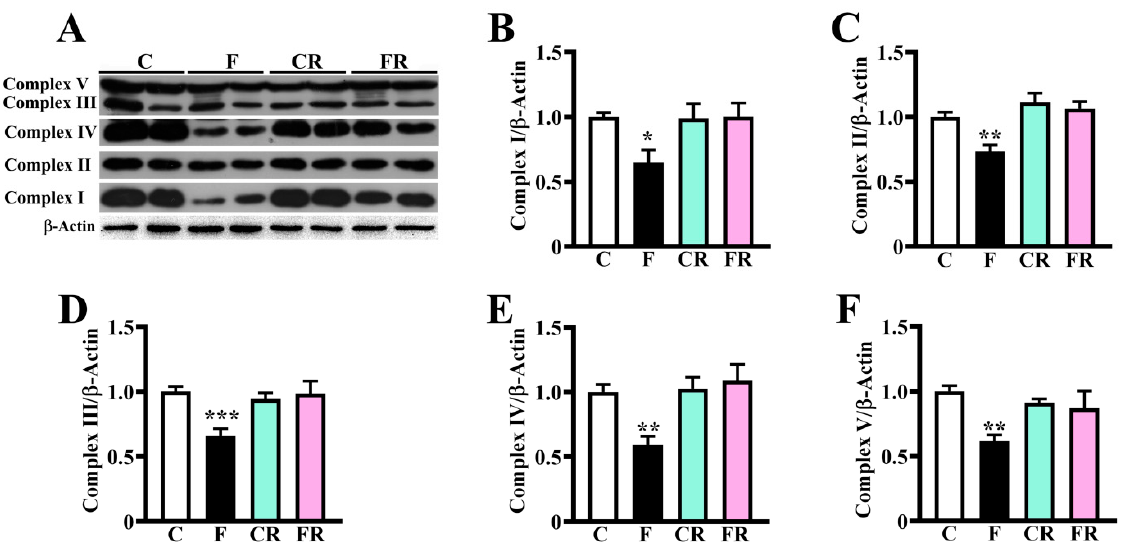
Figure 3. Mitochondrial respiratory complexes amount in rat hypothalamus. The amount of mito- chondrial complex I, II, III, IV, and V was measured in protein extracts from the hypothalamus of control adolescent (C), fructose-fed adolescent (F), young-adult control rescued (CR), young-adult fructose-rescued (FR) rats. Samples were analyzed by 12.5% SDS-PAGE and western blotting. After the detection of immunocomplexes (by mouse anti-OXPHOS and GAM-HRP IgGs) the membrane was stripped and treated with anti- β -actin IgG as the loading control. ( A ) Representative western blotting of respiratory complexes. Panels B-E show results from densitometric analysis. ( B ) Complex I amount relative β -actin; ( C ) Complex II amount relative to β -actin; ( D ) Complex III amount relative to β -actin; ( E ) Complex IV amount relative to β -actin; ( F ): Complex V amount relative to β -actin. Data shown are reported as means ± SEM of eight animals from each group * p < 0.05, ** p < 0.01, *** p < 0.001 versus C (one-way Anova followed by Bonferroni